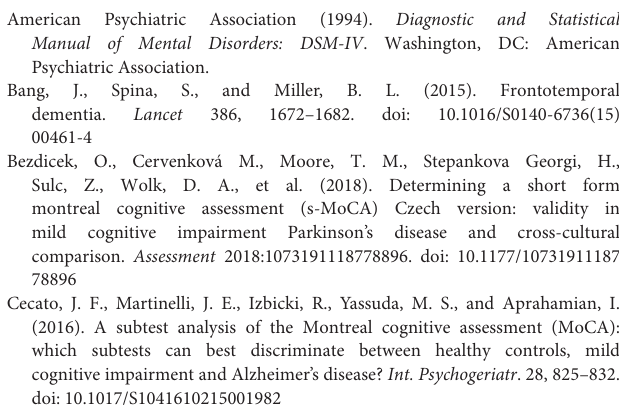
Supplementary Figure 1 | Parallel analysis scree plot of the MoCA. The large ratio between the first and second eigenvalues (4.05) suggests that the MoCA is unidimensional enough for IRT. MoCA, Montreal Cognitive Assessment; IRT, item response theory. Supplementary Figure 2 | Residual correlations produced by the confirmatory factor analysis. Residual correlations smaller than 0.2 support the local independence assumption. Supplementary Figure 3 | Item characteristic curves of the MoCA subitems. MoCA, Montreal Cognitive Assessment. The probability of endorsing an item increases as an individual’s trait level increases, indicating the assumption of